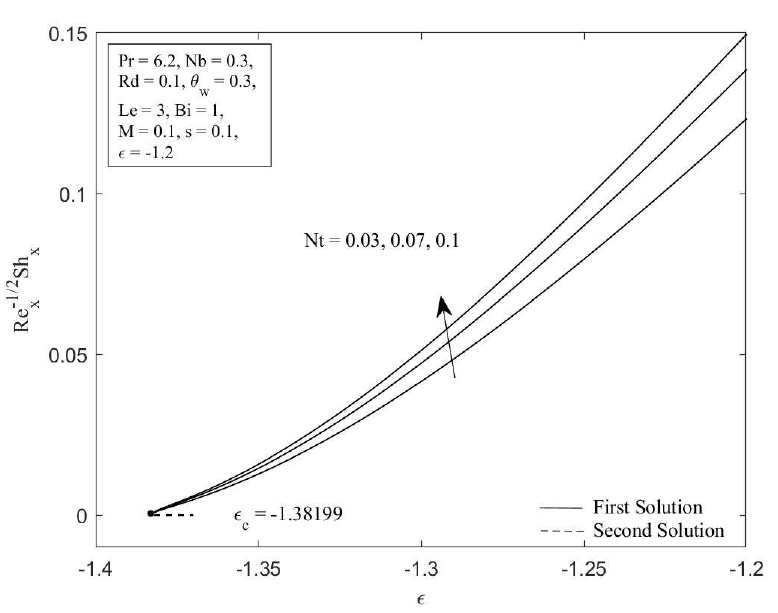
Figure 5. Local Sherwood number Sh x Re − 1/2 x against ε for diverse values of Nt .